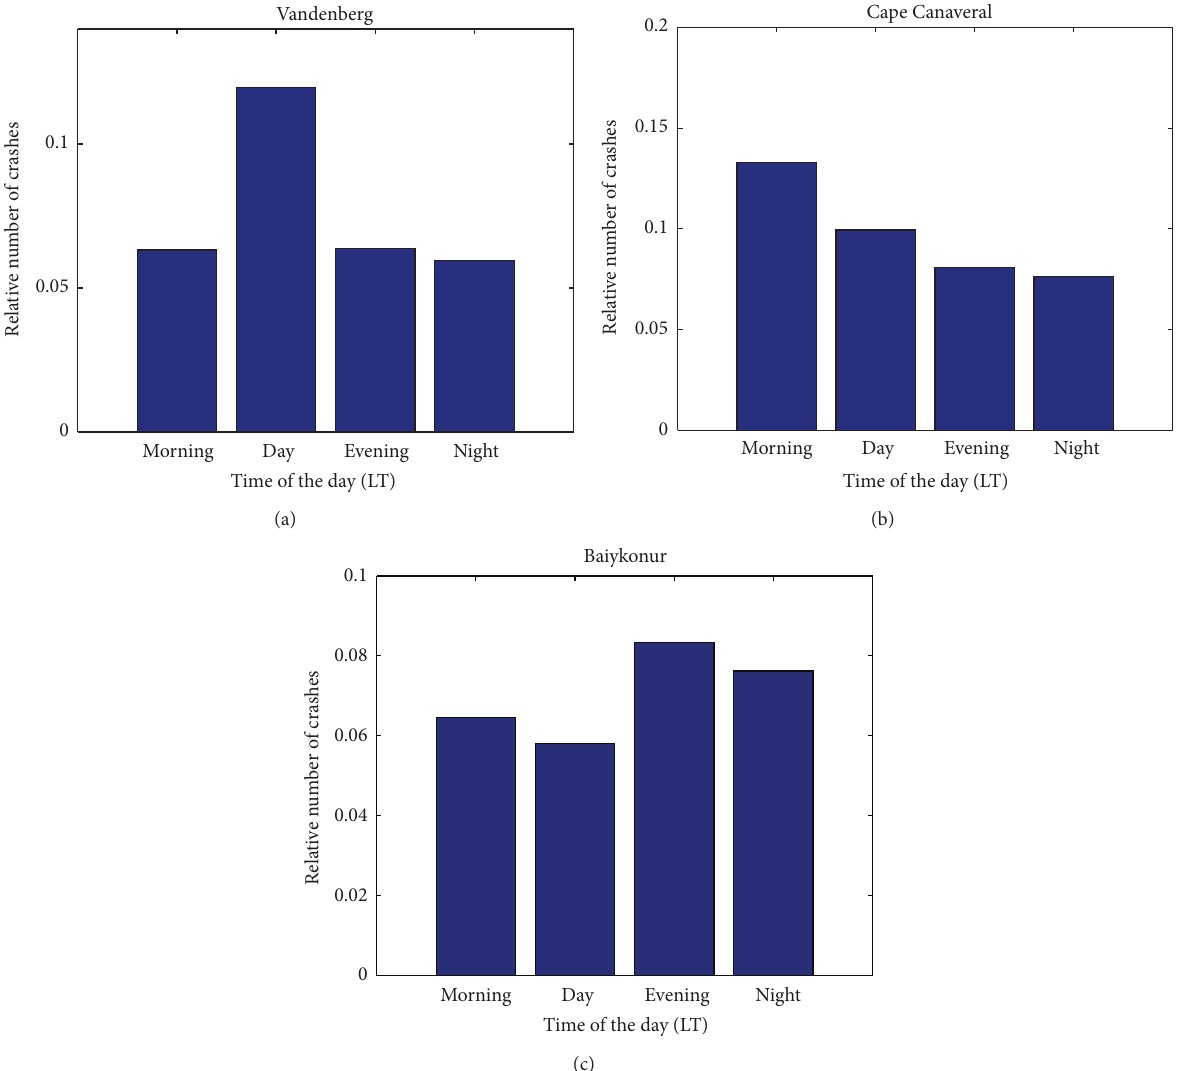
Figure 6: The daily distributions of relative launch crashes at the main space ports: (a) Vandenberg (UT − 8 hr), (b) Cape Canaveral (UT − 05hr), and (c) Baykonur (UT +05hr) depending on LT sector: morning (LT = 06–11), afternoon (LT = 12–17), evening (LT = 18–23), and night (LT =